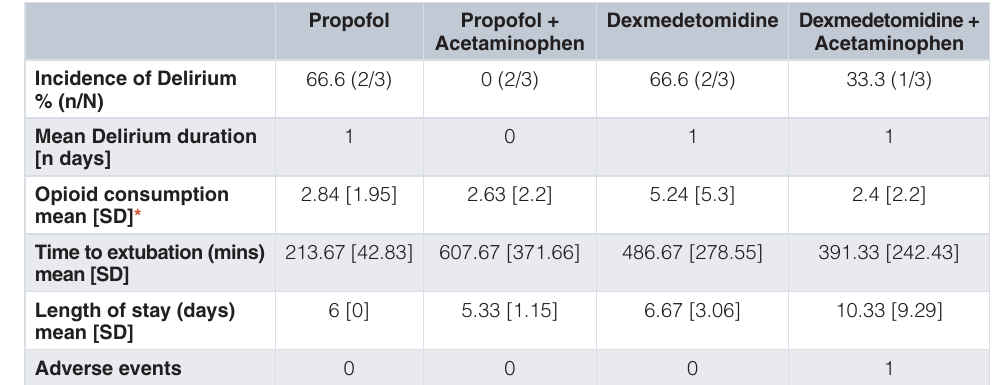
Table 3. Table 3 provides the incidence of delirium and secondary outcomes in the 4 groups in the study namely propofol, propofol + acemaninophen, dexmedetomidine, dexmedetomidine +